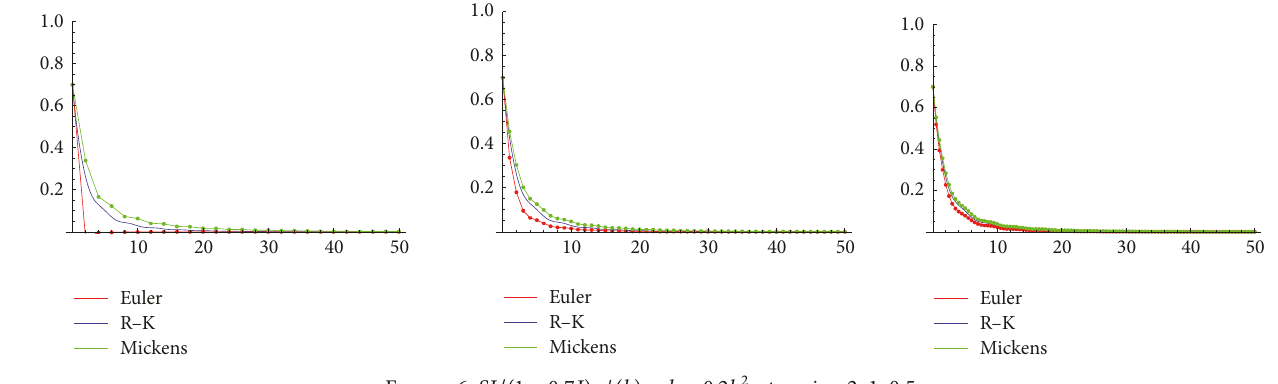
Figure 6: 𝑆𝐼/(1 + 0.7𝐼) ; 𝜙(ℎ) = ℎ + 0.2ℎ 2 ; step-size: 2 , 1 , 0.5 .